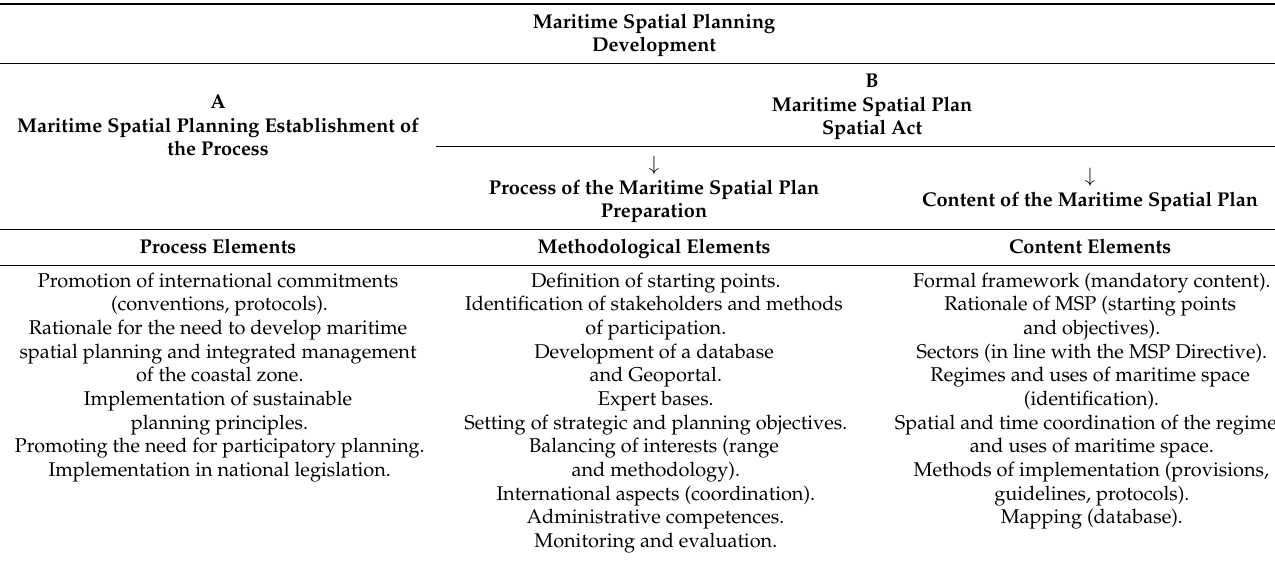
Table 2. Key elements for the development of the maritime spatial planning process, methodology of the plan preparation, and contents of the